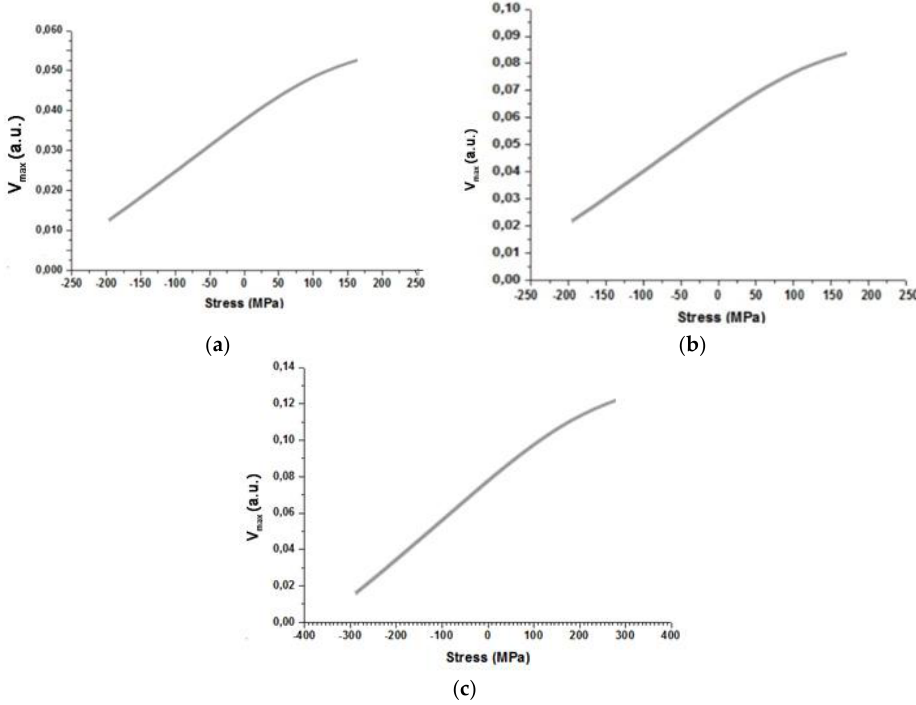
Figure 8. Maximum differential permeability measurements vs. residual stress determined by ND in GTAW welded ( a ) NOES, ( b ) AISI 1008 and ( c ) AISI 4130 steel.